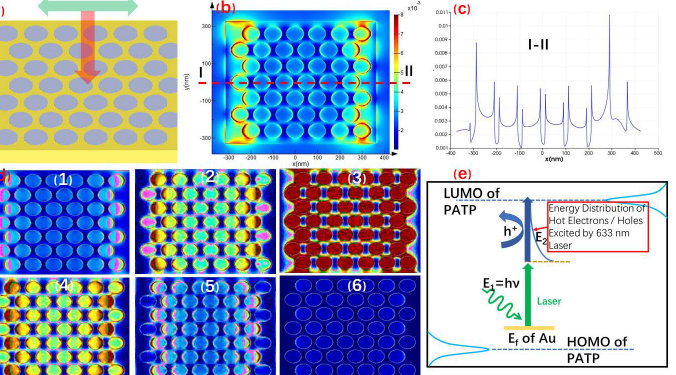
Figure 4. The mechanism of gold nanohole array substrate plasma-driven photocatalysis is as follows: ( a ) theoretical model of gold nanohole array and polarization direction of luminescence simulated by the surface plasmon; ( b ) calculation results of intensity distribution characteristics of the surface plasmon of gold nanohole array; ( c ) analysis of intensity distribution simulated by the surface plasmon of gold nanohole array; ( d ) surface plasmon distribution of gold nanohole array; ( e ) the mechanism of Au nanohole array substrate plasma-driven